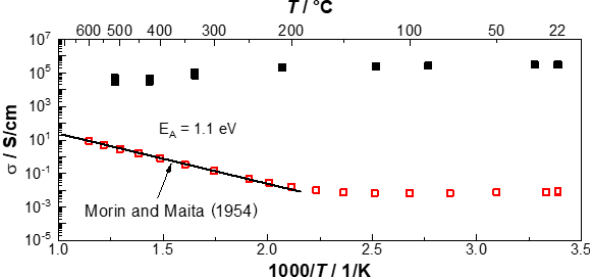
Figure 9. Arrhenius-like representation of the measured temperature-dependent electrical conductivity of a gold thin film (thickness 200nm) and a boron-doped silicon wafer (thickness 380µm) up to 600 ◦ C, with an additional comparison of the intrinsic conductivity of silicon (adapted from Morin and Maita,